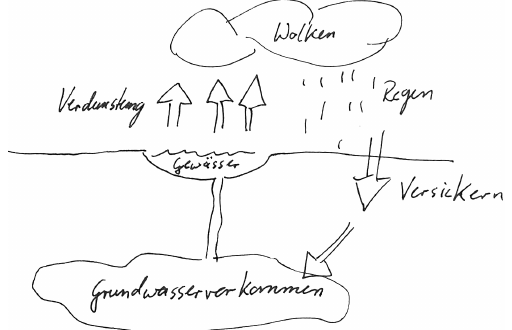
Figure 5. Examples for the categories of analysis. Groundwater as a subterranean lake. Wolken (clouds), Verdunstung(evaporation), Re-